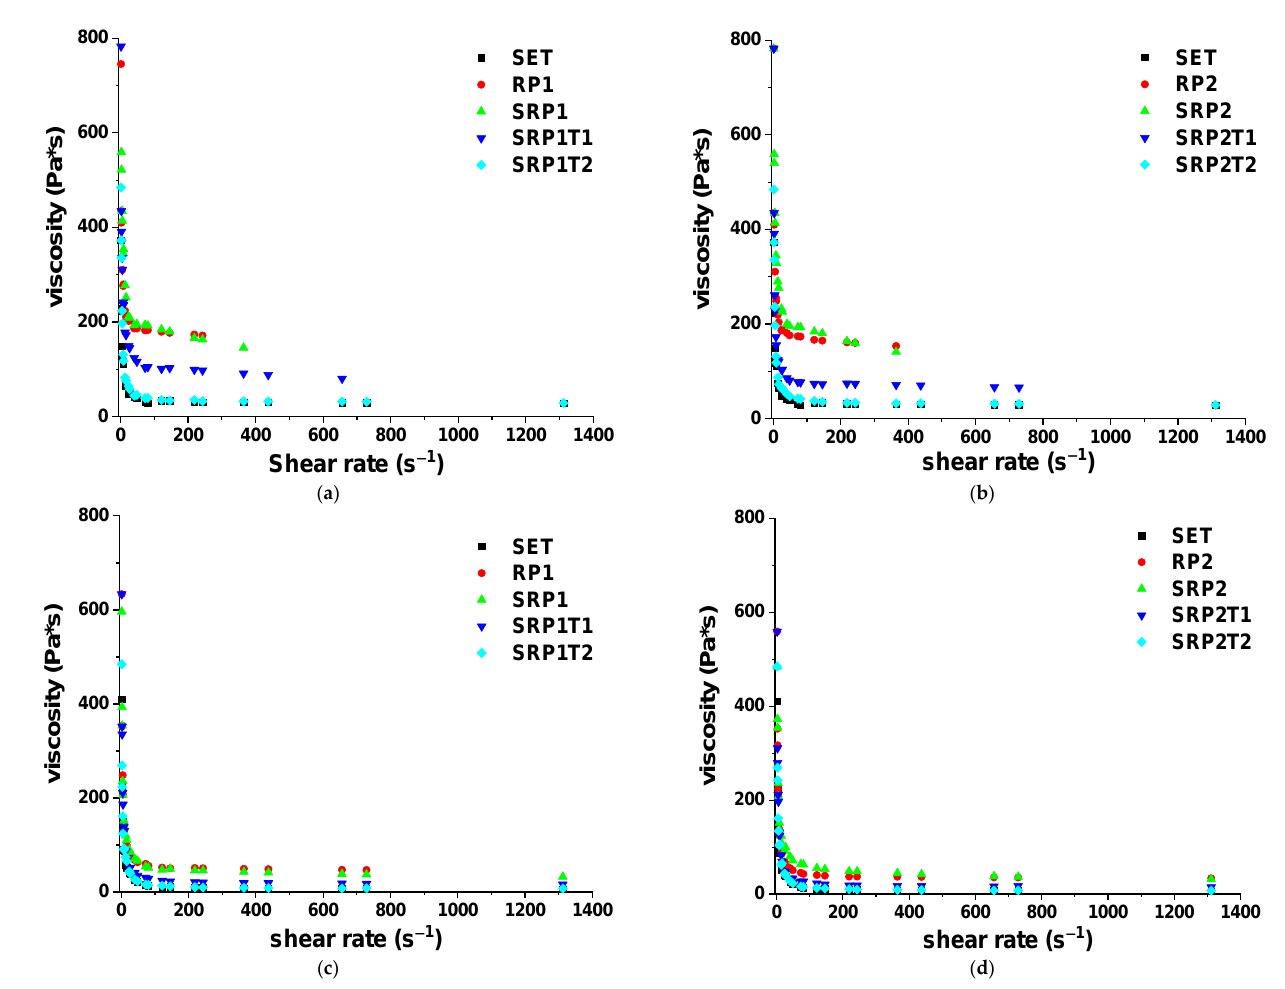
Figure 3. The effects of SET and TEGDN upon the viscosity of polyester-polyols.